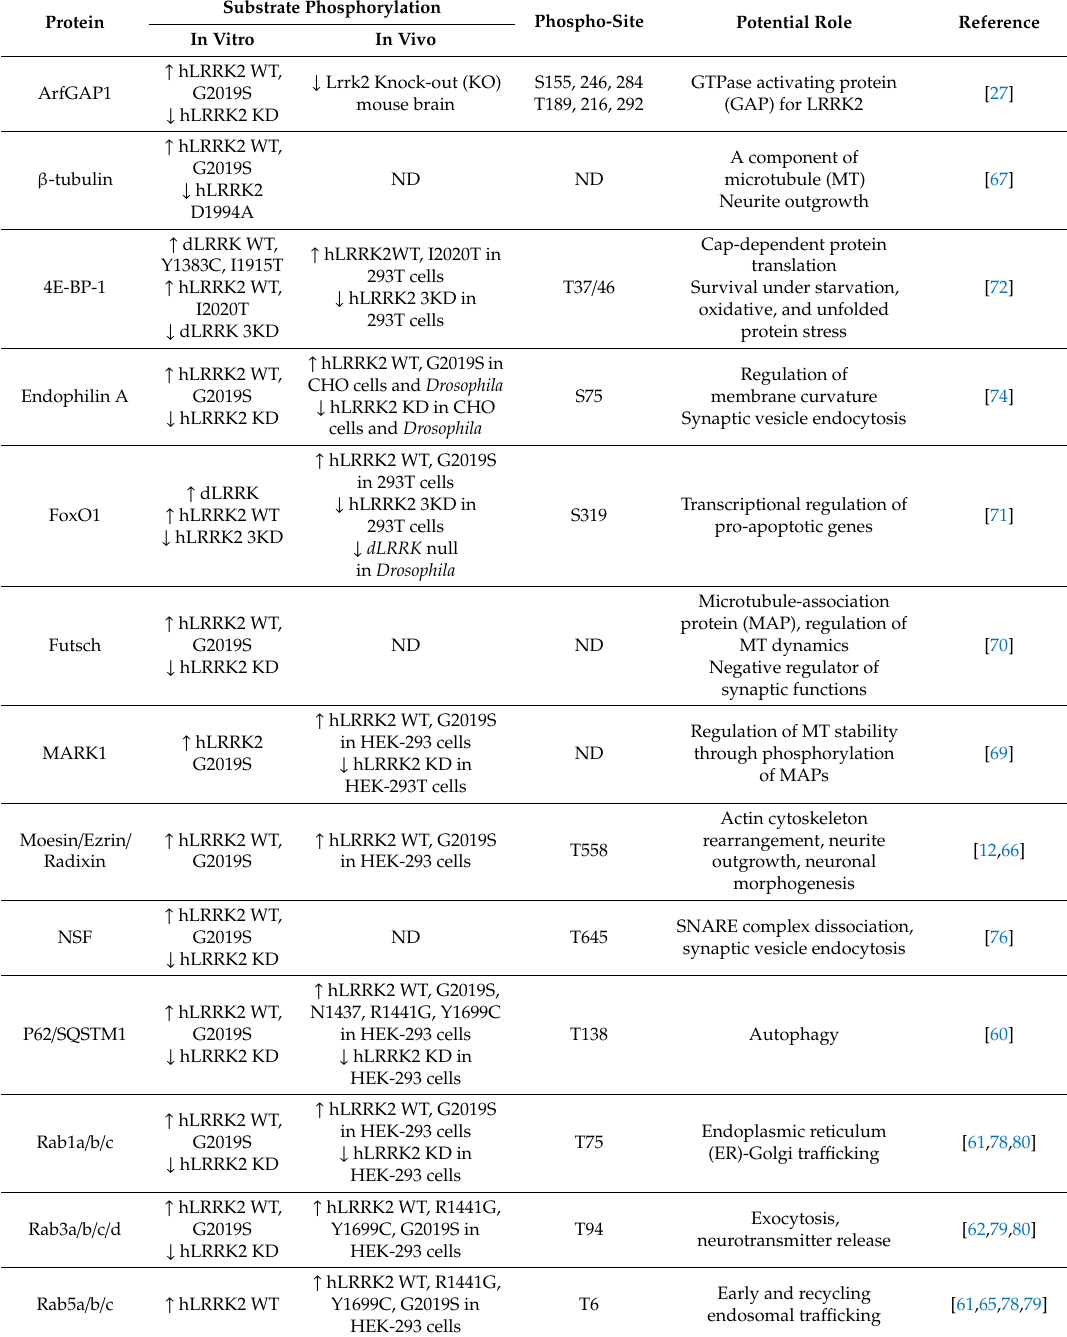
Table 1. The list of LRRK2 kinase substrates and their potential